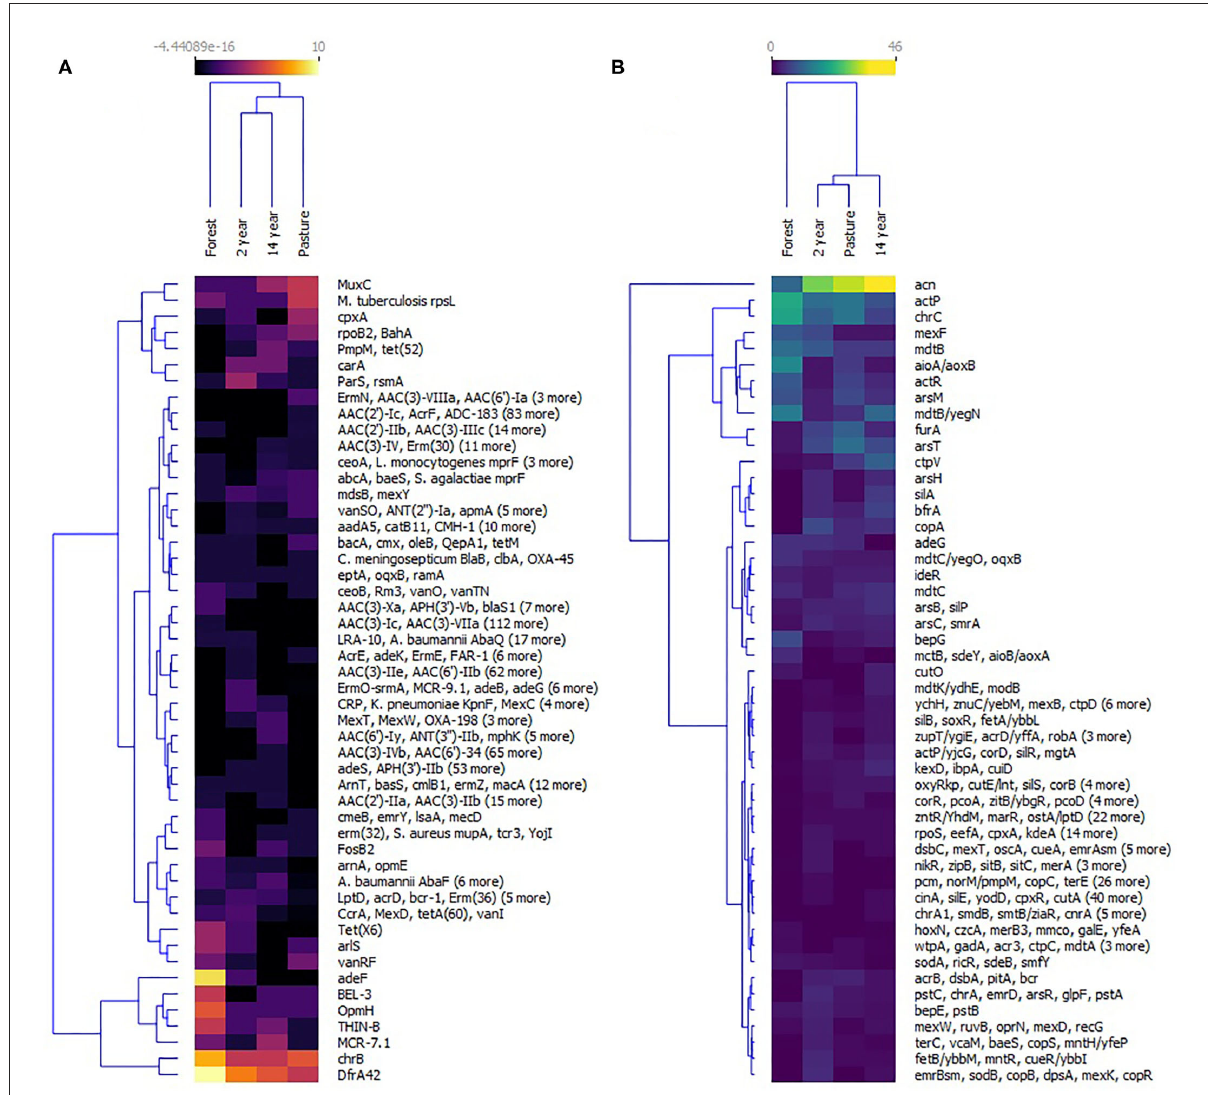
FIGURE7 Heat map of (A) antibiotic resistance genes and (B) biocides resistance genes identified at collection sites—grouped using the k-means